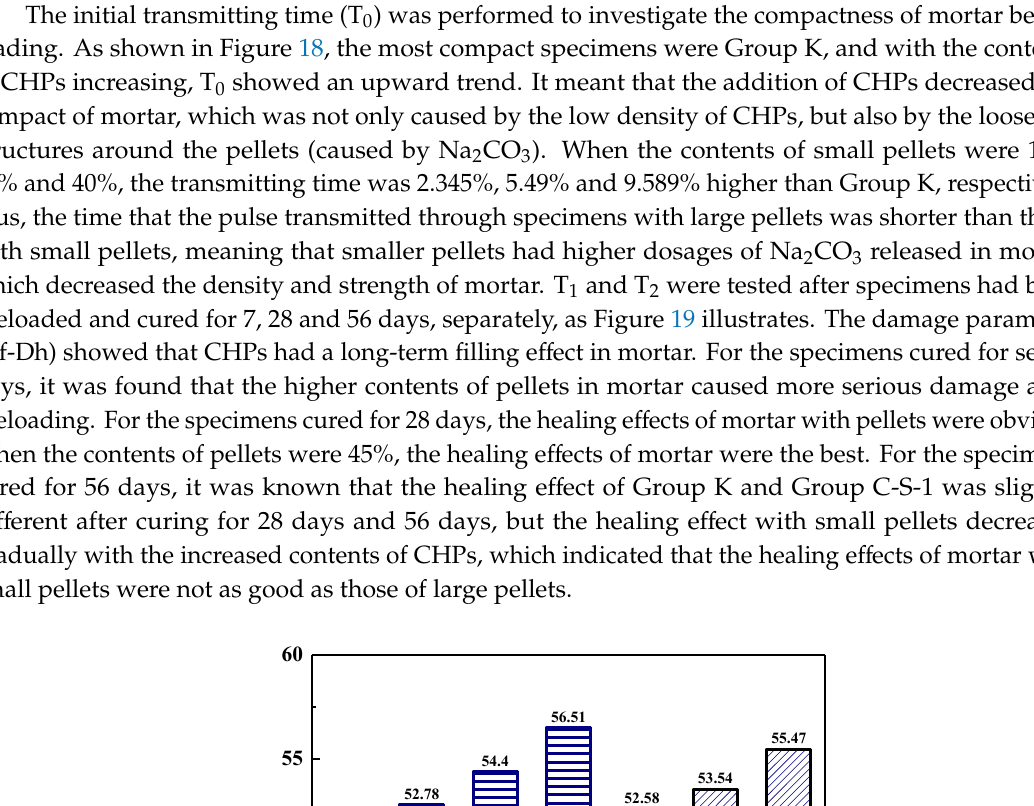
Figure 19. The increment of damage parameter at different curing ages. 3.4.2. Passive AE In this study, the energy produced by the loading process to 60% F max was accumulated. The energy ratio is shown in Figure 20. For the first seven days, Group K showed the highest energy recovery ratio, which was the highest flexural strength healing rate, too. With the contents of pellets increasing in mortar, the energy recovery ratios were gradually decreased. It means that the addition of CHPs decreased the early healing ability of mortar. For the curing age of 28 days, there was an obvious increase in the energy recovery ratios of the mortar with CHPs, which meant that pellets had a good healing efficiency on concrete than Group K in this period. The energy recovery ratios were gradually increased with the contents of pellets increasing. It means that the addition of CHPs increased the bonding strength of mortar, which produced higher energy during loading. For the curing age of 56 days, the increase in energy recovery ratios was a little less. The groups introduced with CHPs had a better healing effect than Group K. Groups C ‐ S ‐ 2 and C ‐ L ‐ 2 had the highest energy recovery ratio, while the 40% contents of CHPs had a worse energy recovery ratio. It could be concluded that the flexural strength healing ratios of mortar were improved by CHPs. When the content of CHPs was 25%, the highest flexural strength of the mortar was after healing.